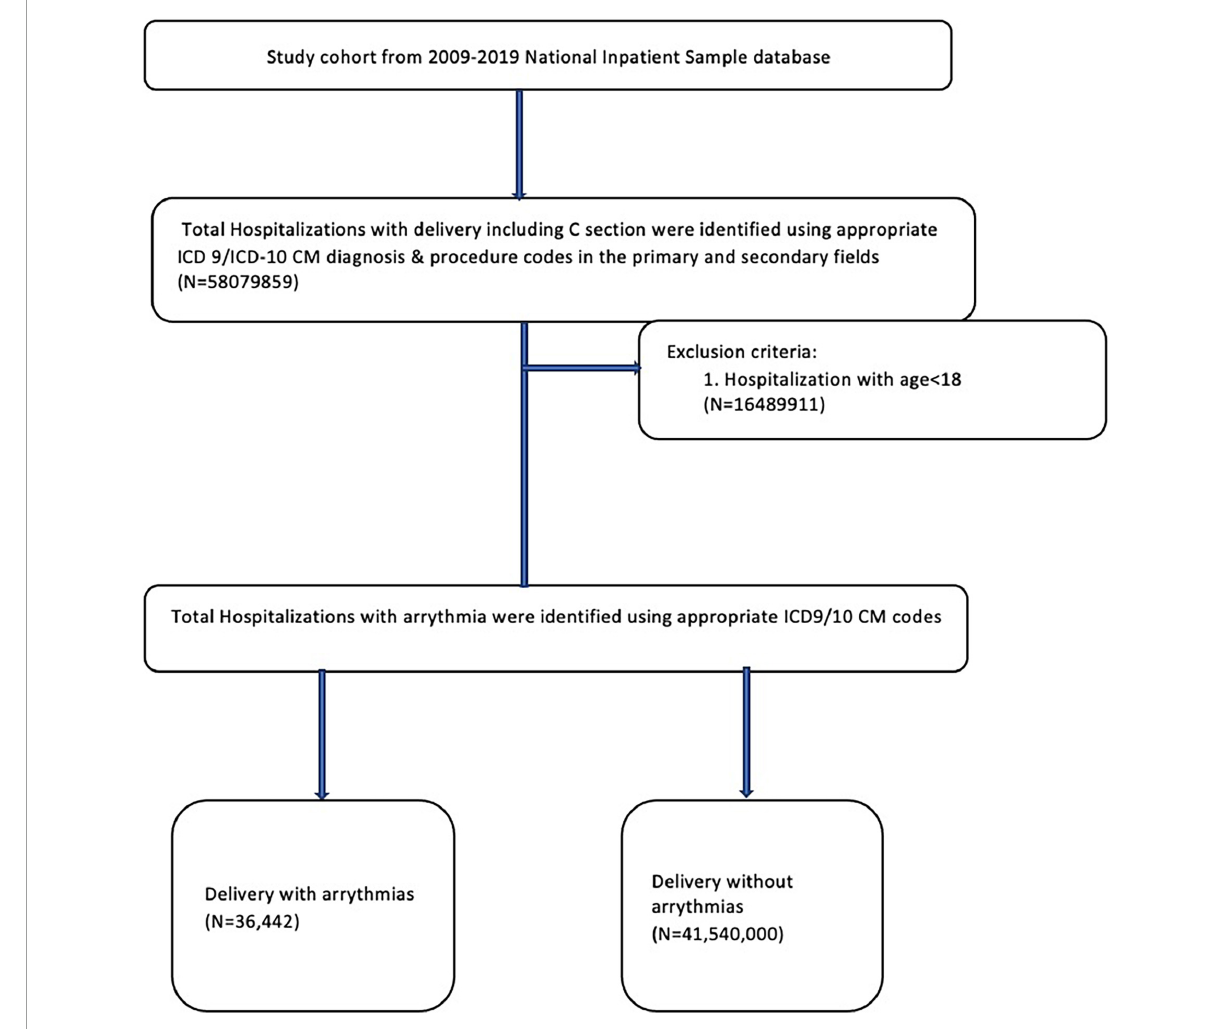
FIGURE1 Study population selection algorithm from the National Inpatient Sample database from 2009 to